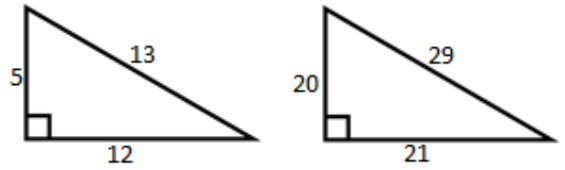
Figure 1. An illustration of Pythagorean triples.